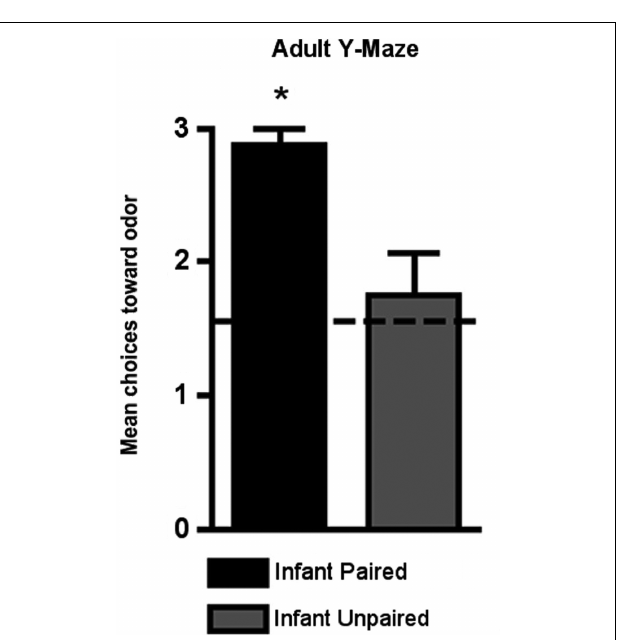
FIGURE 7 | Adult rats were tested in a Y-maze following infant odor-shock conditioning to assess whether the odor preference was retained into adulthood. The Infant Paired/Adult Naïve rats demonstrated a preference compared to the Infant Unpaired/Adult Naïve control group ( n = 7–8/group). Asterisk represents a signifi cant difference from each of the other groups ( p < 0.05).